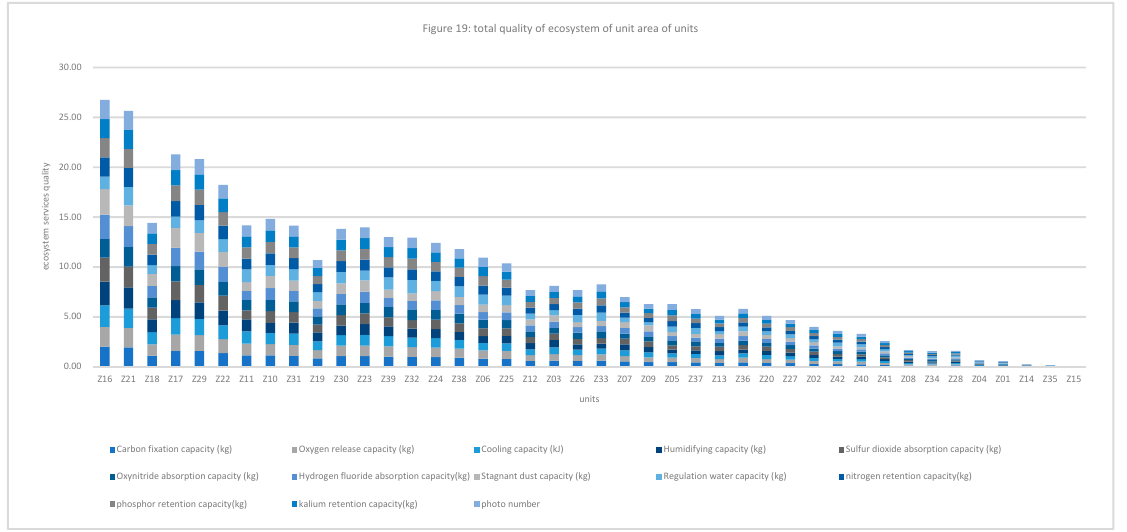
Figure 6. Total quality of ecosystem of areas of units.